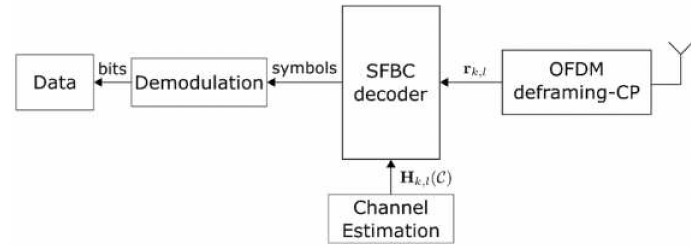
Figure 3. Block diagram of ISAC communication